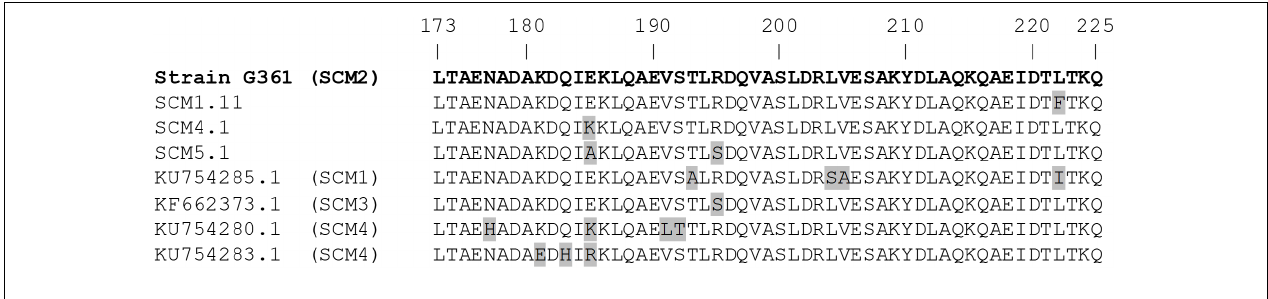
FIGURE 3 | Alignment of predicted amino acid sequences of IgG binding regions in SCM group I proteins. The IgG binding region derived from isolate G361 comprising amino acids 173 to 225 of the mature protein (Bergmann et al., 2017) was used as reference and corresponds to the consensus of predicted SCM group I proteins. Representative alleles of sequences found in our study are indicated by their numbers and sequences found elsewhere by their GenBank numbers.